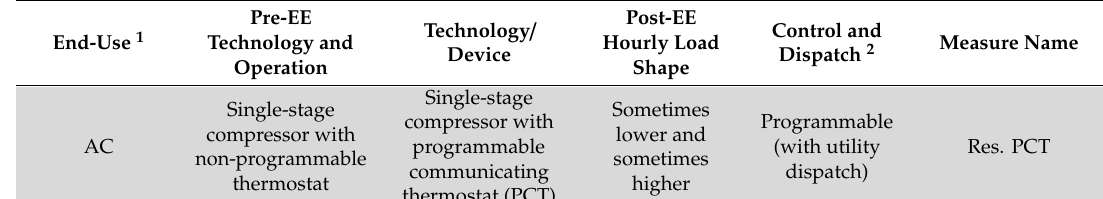
Table 2. Example residential measure